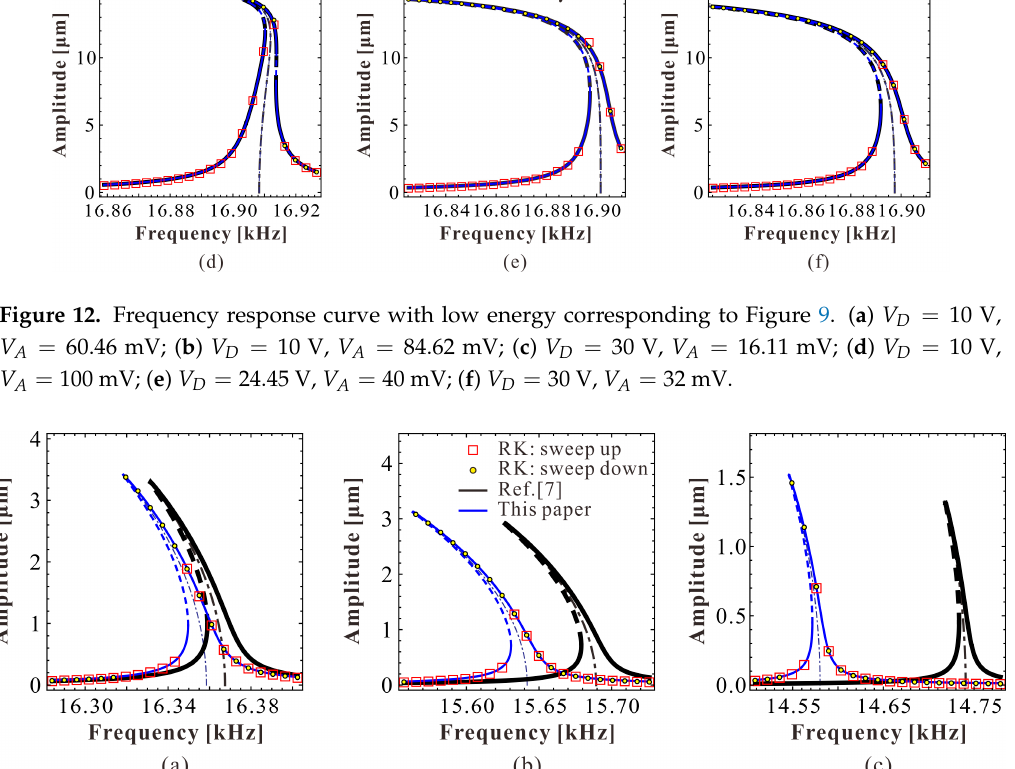
Figure 13. Frequency response curve with low energy as the DC voltage increases. ( a ) V D = 200 V, V A = 1 mV; ( b ) V D = 300 V, V A = 0.6 mV; ( c ) V D = 400 V, V A = 0.2